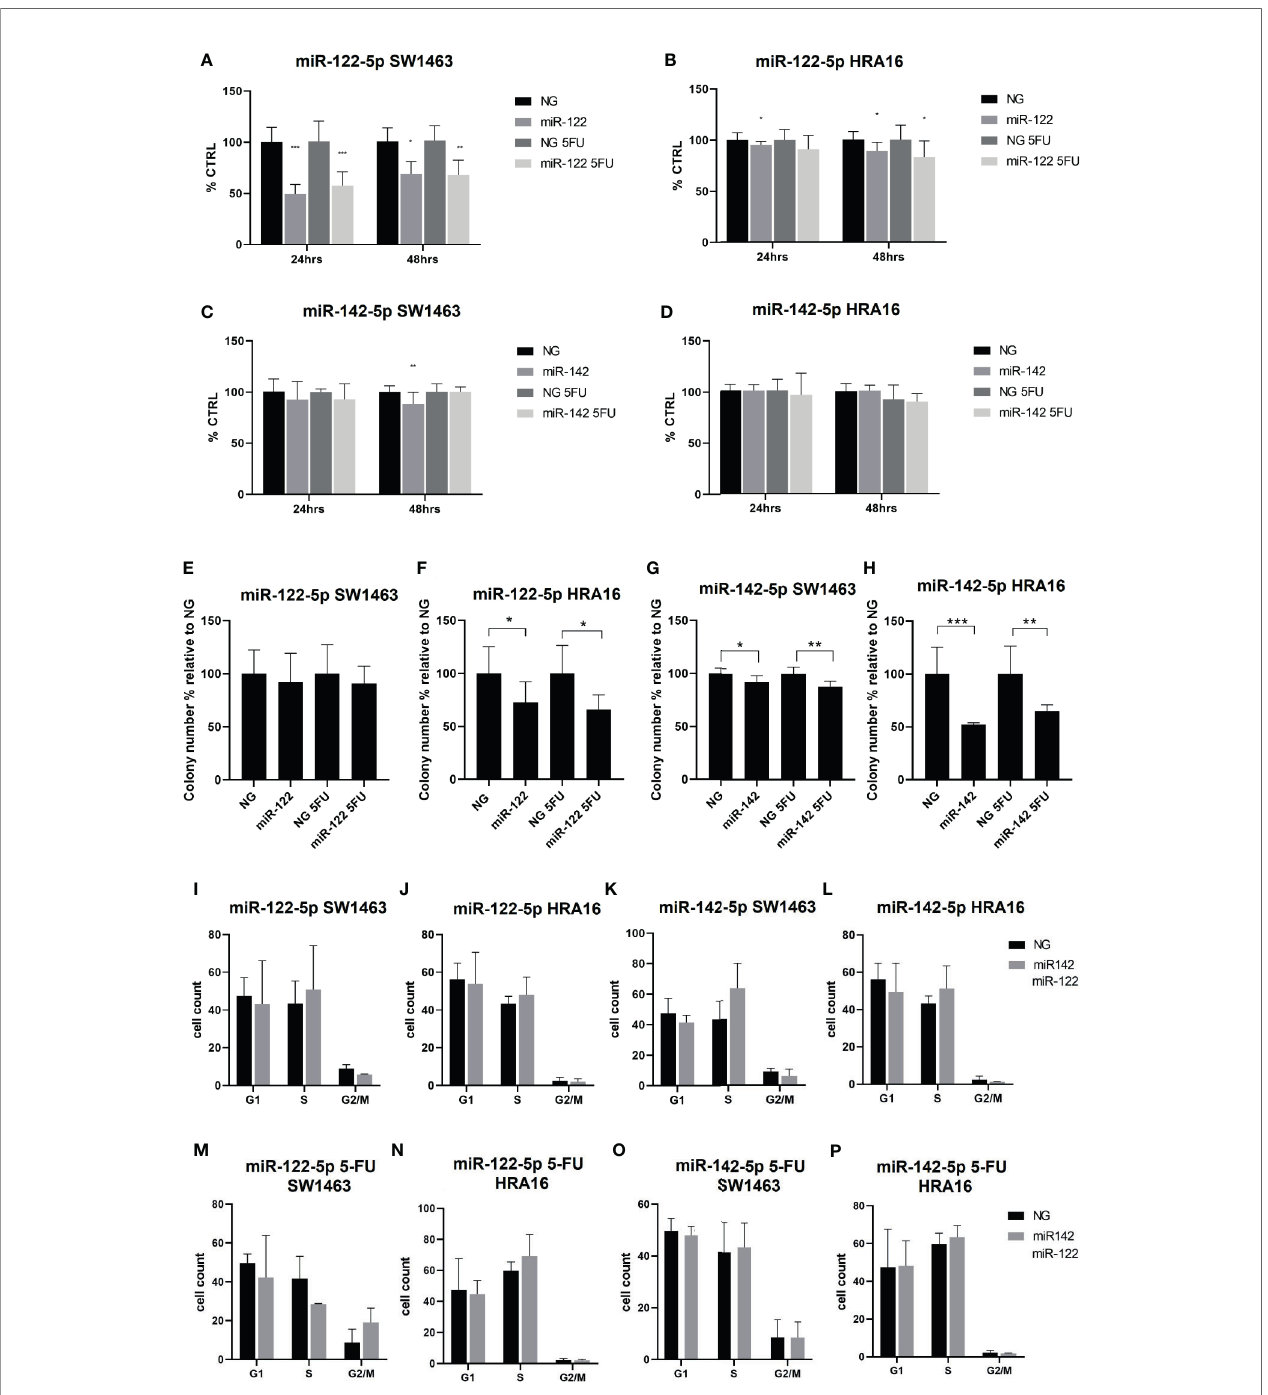
FIGURE 4 | Cell-culture-based assessment. The effect of miR-122-5p and miR-142-5p on cell proliferation (A – D) , colony-forming activity (E – H) , and cell cycle distribution (I-P) in rectal cancer cell lines. (A, B) - A signi fi cant decrease in cell proliferation of SW1463 cells after the miR-122-5p transfection (A) was observed after both 24h and 48h (24h: without 5-FU: p<0.001, with 5-FU: p=0.0003; 48h: without 5-FU: p=0.2, with 5-FU: p=0.008). Same trend was recorded for HRA16 [ (B) , for 24 h: p=0.05, for 48 h: p= 0.04]. (C, D) miR-142-5p transfection had a moderate impact on SW1463 proliferation [ (C) , p=0.007] but no effect on HRA16 proliferation (D) . (E, F – H) Both HRA16 and SW1463 transfected with miR-122-5p and miR-142-5p mimics formed signi fi cantly fewer colonies than those transfected with control oligonucleotide (miR-122-5p: SW1463 - no signi fi cant results, HRA16 – p=0.05; miR-142-5p: SW1463 – p=0.02, HRA16 – p=0.001). The same effect was also observed after the 5-FU administration (miR-122-5p + 5-FU: SW1463 – no signi fi cant results, HRA16 – p=0.01; miR-142-5p + 5FU: SW1463 – p=0.0008, HRA16 – p=0.005). (I – P) No signi fi cant change in cell cycle progression after miR-122-5p and miR-142-5p transfection was observed. *p ≤ 0.05, **p ≤ 0.01, ***p ≤